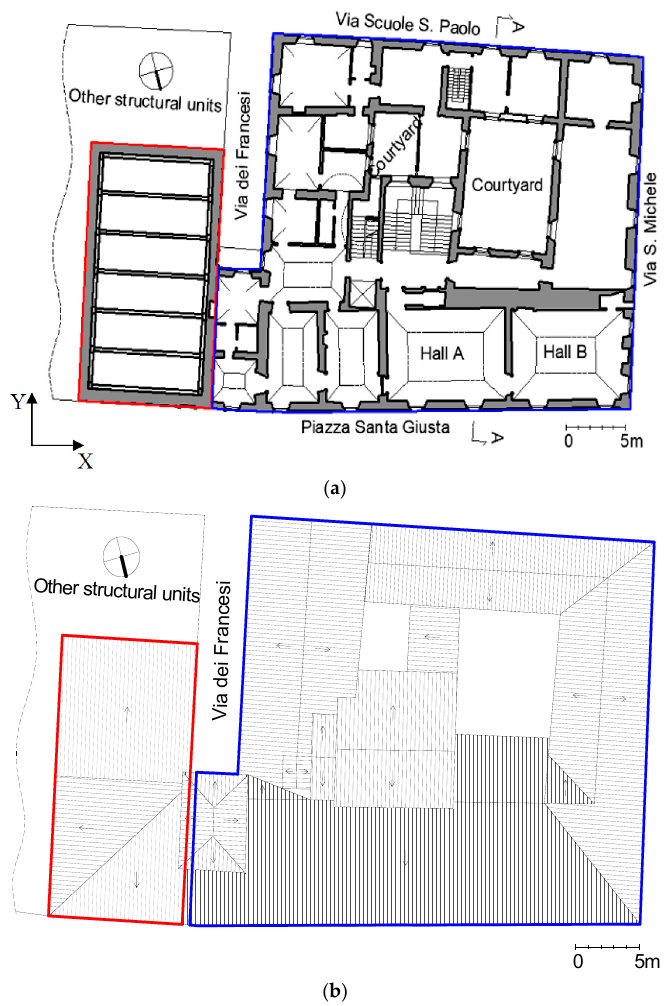
Figure 1. Plans: ( a ) of the first level; and ( b ) of the roof, with indication of the main body of the building (contoured in blue) and of the secondary reinforced concrete body (contoured in red). Reproduced with permission from [18].